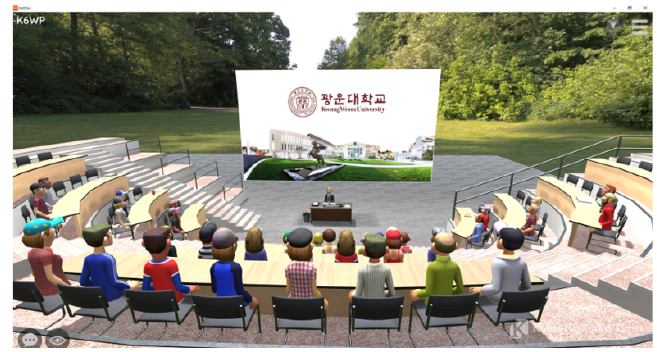
Figure 16: Kwangwoon University Metaverse platform, South Korea